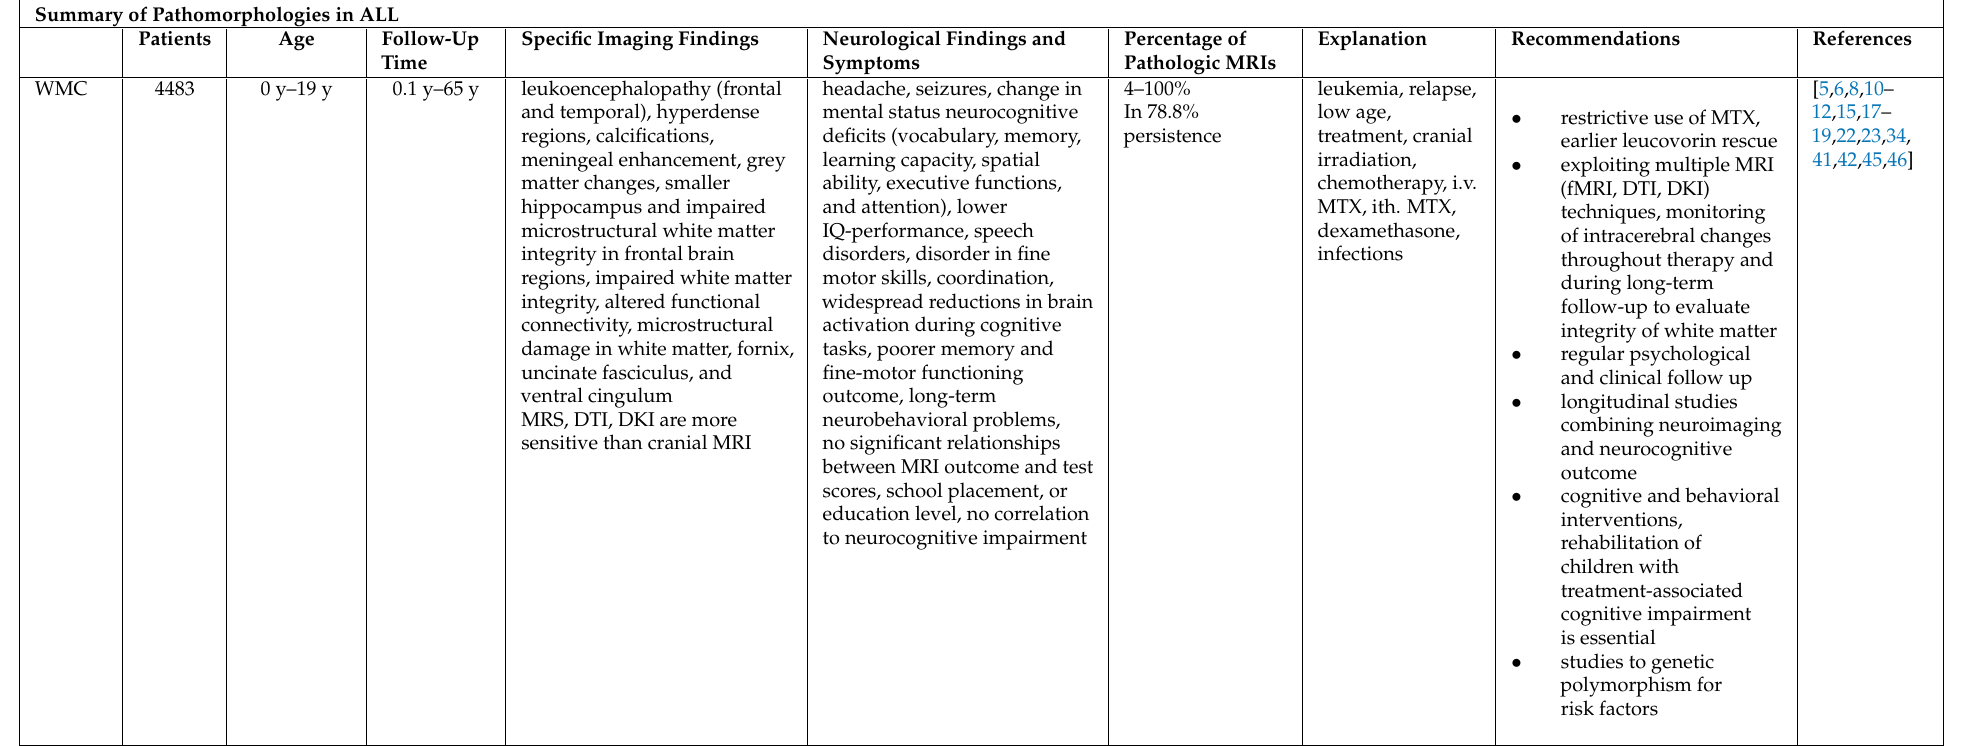
Table 4. Summary of pathomorphologies without ventricle width (GDAH) based on literature. (Age and Follow-up time: (d: day; m: months; y: years); BA: brain atrophy; BBB: blood brain barrier; CNS: central nervous system; DTI: diffusion tensor imaging: DKI: diffusional kurtosis imaging; fMRI: functional MRI; HR: high risk; ith.: intrathecal; n.d.: not done; MRS: magnetic resonance spectroscopy; NT: neurotoxicity; PREST: posterior reversible leukoencephalopathy syndrome; SIADHS: syndrome of inappropriate antidiuretic hormone secretion; ST: sinus vein thrombosis; TIT: intrathecal triple drug (MTX, cytarabine, prednisone); WMC: white matter